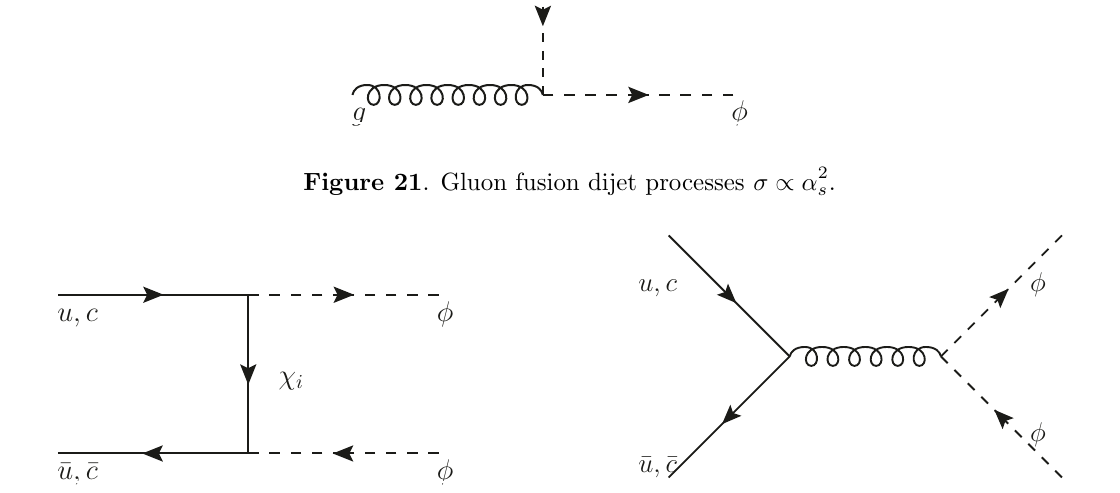
( (cid:21)(cid:21) y ) 2 ( (cid:11) 2 ) and so the dominance depends on the size s /